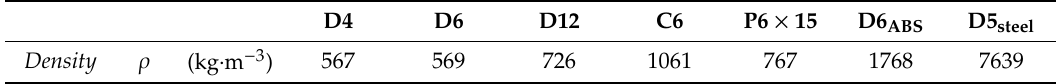
Table A2. Calibrated DEM particles’ densities.